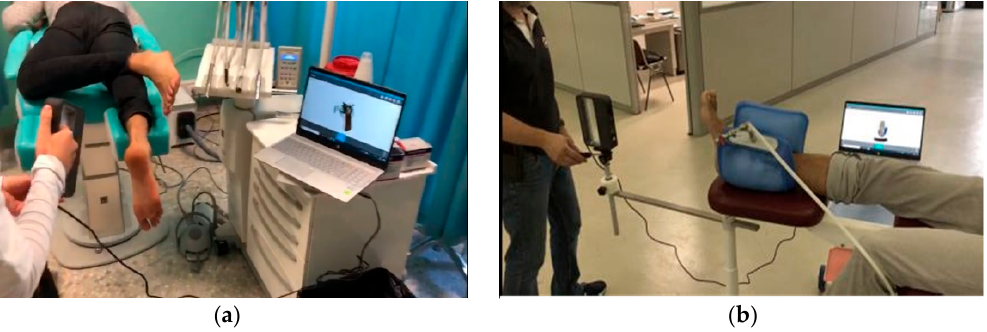
Figure 2. Scanning of the foot without any foot locking system and a handheld 3D scanner ( a ), and scanning of the foot with a foot locking system and a tripod for the 3D scanner ( b ). Table 2. Comparison of ten scans of the foot without any foot locking system and with a handheld 3D scanner.